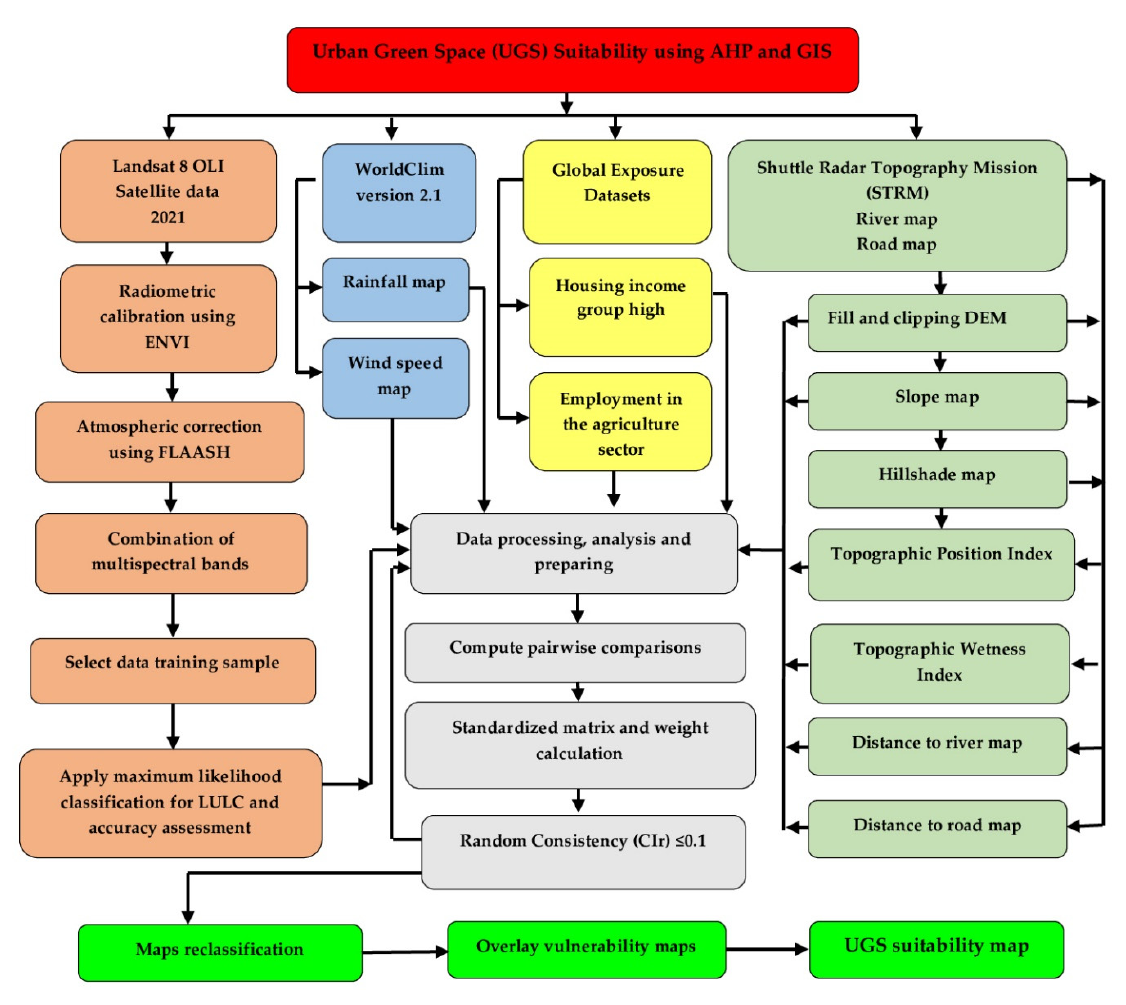
Figure 5. Flowchart used in this study.